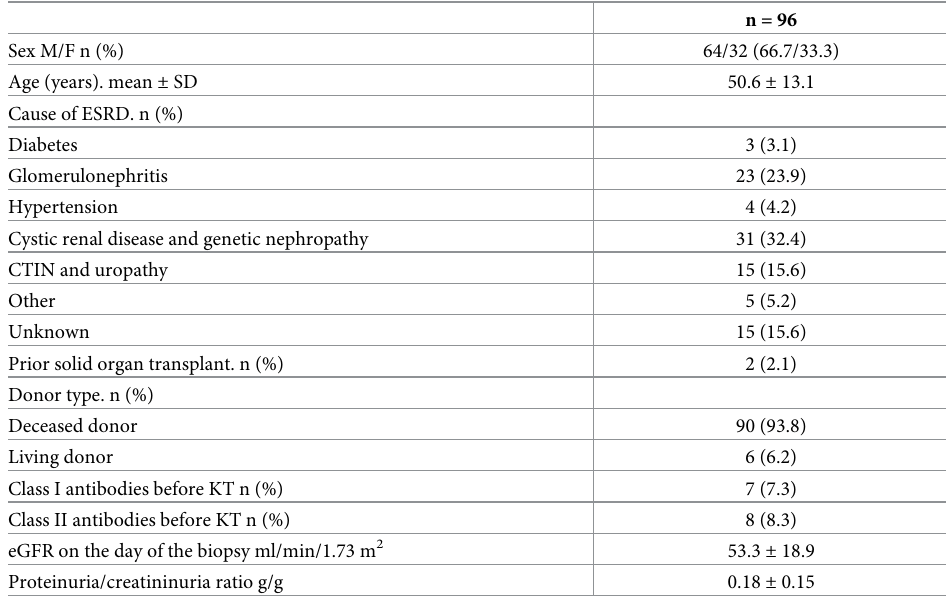
Table 2. Baseline